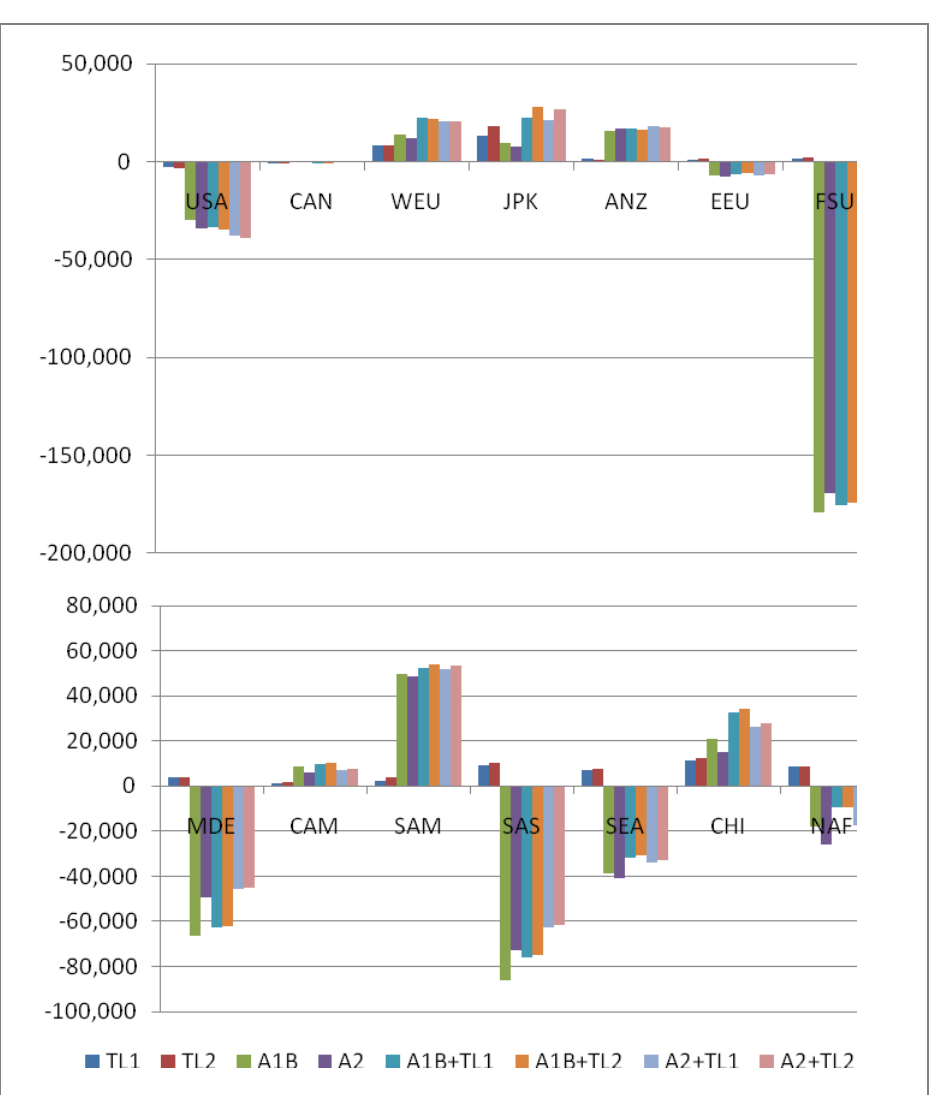
Figure 7. Change in welfare for 2050 (in Mio USD) relative to the baseline.